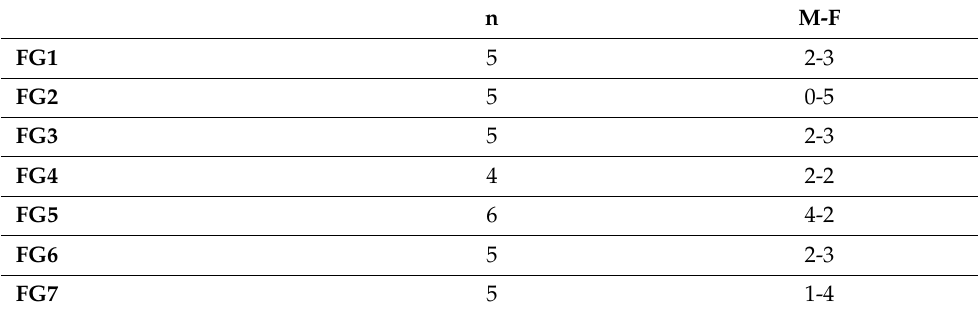
Table 1. Focal Groups